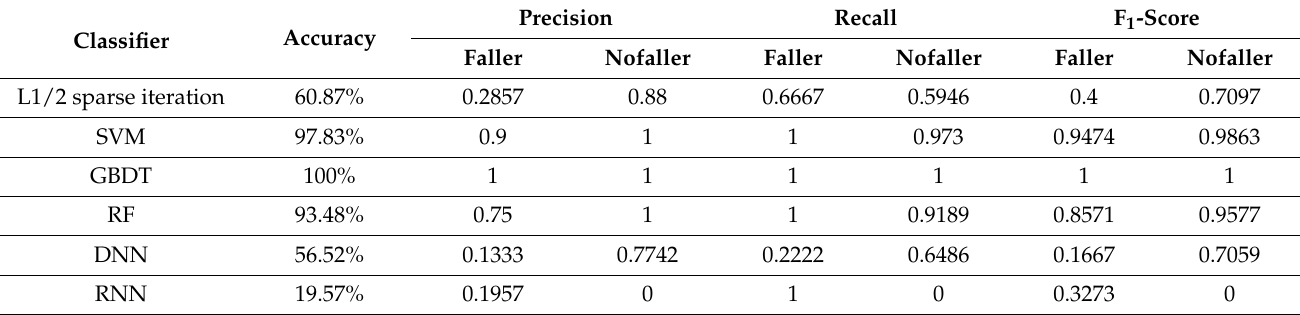
Table 4. Performance evaluation indexes of different classifiers.